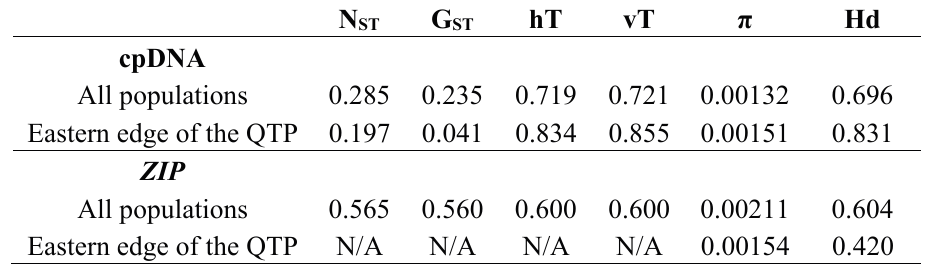
Figure 1. Haplotype distribution of cpDNA ( A ) and ZIP ( B ) in Thlaspi arvense . Pie charts show haplotype proportions in each population. Multimodality mismatch distribution curves of cpDNA and ZIP in the overall populations are shown in A1 and B1. The networks of the 11 chloroplast haplotypes and six nuclear alleles are shown in A2 and B2, separately. Black dots represent missing haplotypes. Table 2. Parameters of population diversity in all populations and those positioned at the eastern edge of the Qinghai-Tibetan Plateau